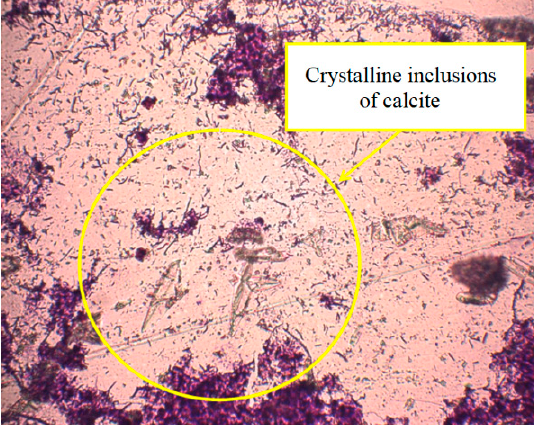
Figure 6. Crystalline structure formation during the process of digestion in the sewage sludge and phosphogypsum under sulphate-reducing conditions. Light microscopy. Gram staining. Magnification ×100.